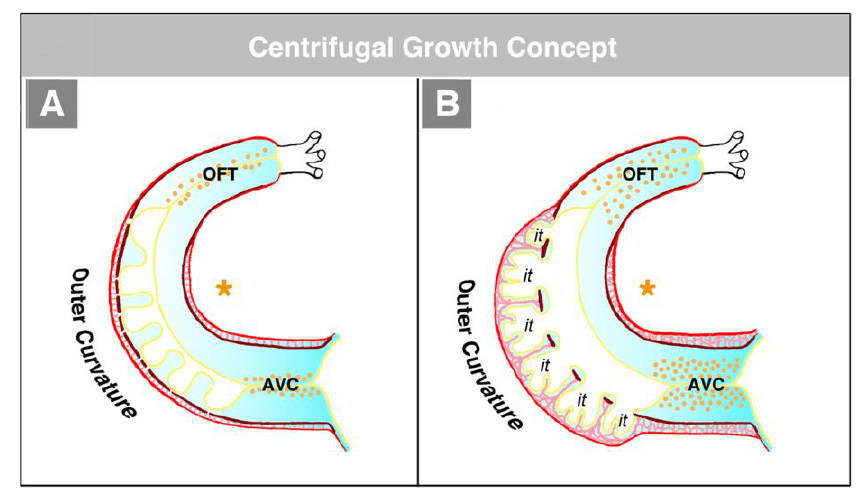
Figure 13. These schematic drawings illustrate the centrifugal growth concept of ventricular trabeculation. ( A ) Initial step of trabeculation. ( B ) Advanced step of trabeculation. According to this concept, myocardial trabeculae are formed mainly from cardiomyocytes of the middle (reticular) layer of the ventricular myocardium (marked by light red color). The endocardium-lined intertrabecular spaces ( it ) arise from the sprout-like endocardial protrusions of the trabecular shields. These sprouts penetrate the inner (basal) layer of the ventricular myocardium and start an invasion of the intramyocardial ECM of the reticular layer myocardium ( A ). Signals from the endocardium of the intertrabecular spaces stimulate growth of the reticular/trabecular myocardium, which leads to expansion (ballooning) of the embryonic ventricles ( B ). Note that the free edges of the myocardial trabeculae are remnants of the original inner (basal) layer of the primary myocardial tube. Color code: orange asterisks mark the inner curvature of the ventricular bend; dark red = remnants of the inner (basal) layer of primary myocardium; red = derivatives of the outer (apical) layer of the primary myocardium; light red = reticular layer of primary myocardium; light blue = CJ and intramyocardial ECM; yellow = endocardium. Abbreviations: AVC = atrio-ventricular canal; it = intertrabecular spaces; OFT = outflow tract.